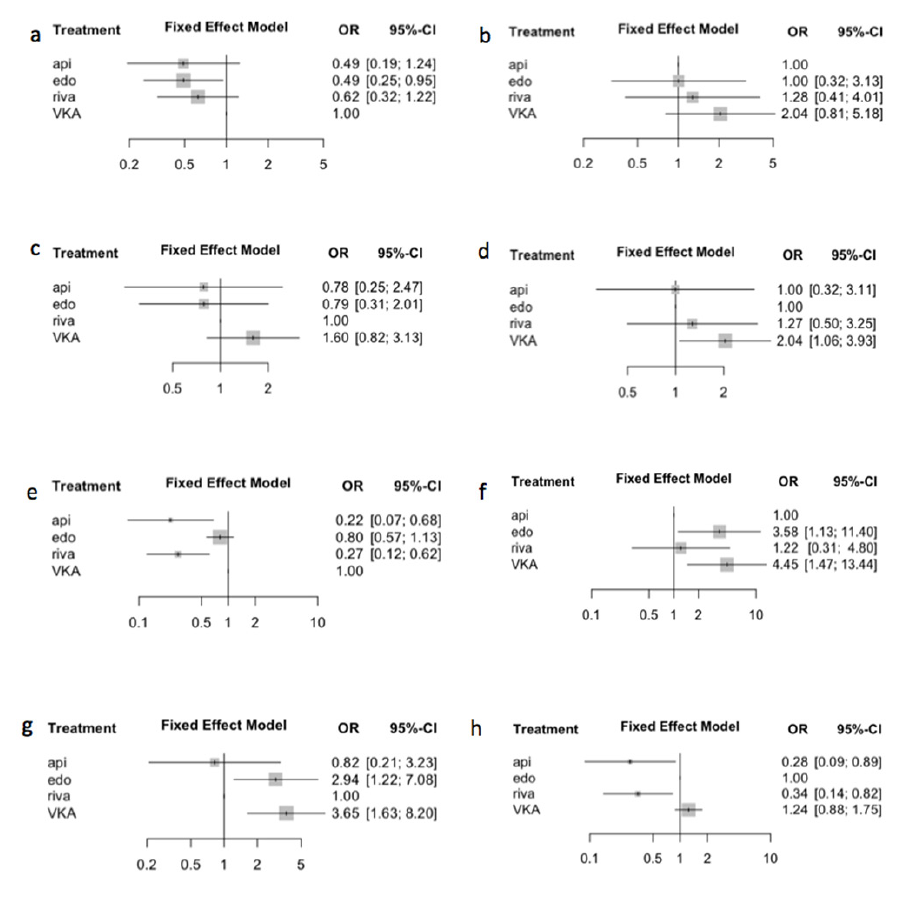
Forest plots of indirect comparisons between direct oral anticoagulants for composite endpoints recurrent venous thromboembolism or venous thromboembolism-related death (a–d) and clinically relevant non-major bleeding (e–h). api = apixaban; CI = confidence interval; edo = edoxaban OR = odds ratio; riva = rivaroxaban; VKA = vitamin K